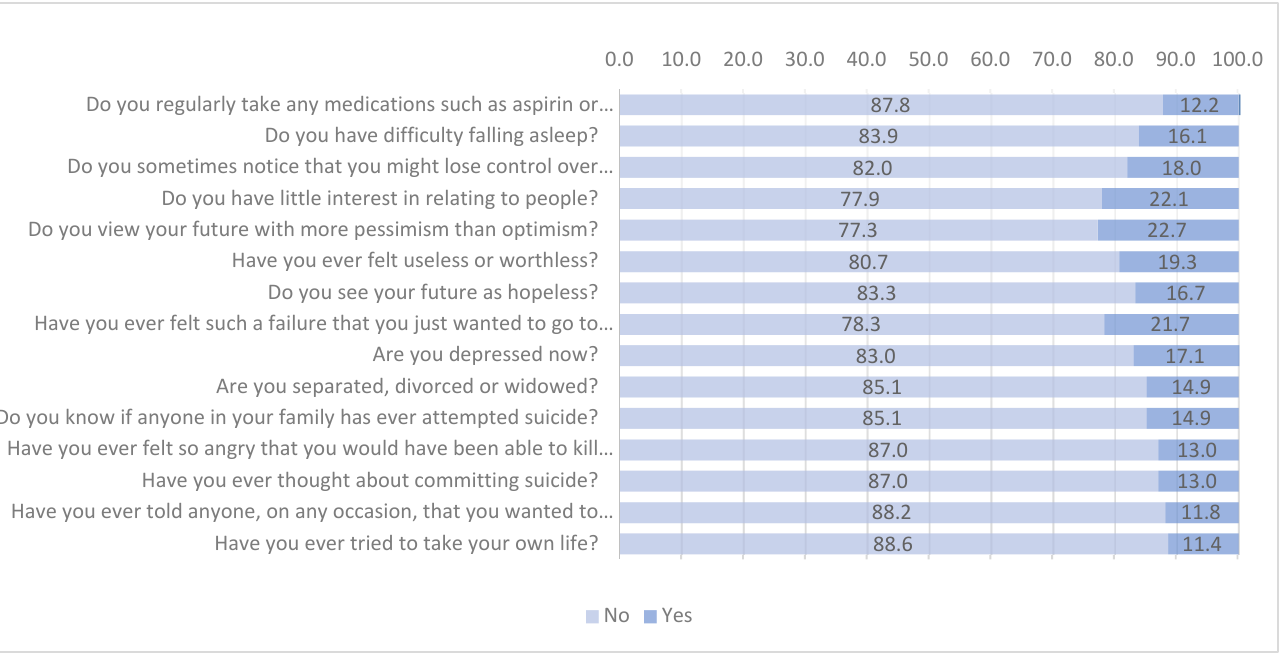
Figure 1. Frequency of responses according to each item of the Plutchik suicide risk scale. In the bivariate analysis (Table 2), significant differences were found in the prevalence of SR, according to being single (16.2% single vs. 7.6% no single, p = 0.014), having children (8.8% children vs. 9.9% no children, p = 0.042), working time (8.8% 19 months or more vs. 19.2% 1 to 6 months, p = 0.047), family history of mental health (40.9% family history vs. 12.8% no family history, p < 0.001), insomnia (44% severe clinical insomnia vs. 11.3% absent insomnia, p < 0.001), resilience (7.1% high resilience vs. 19.4% low resilience, p < 0.001). Likewise, with mental health outcomes, anxiety (63.6% severe anxiety vs. 8.2% no anxiety, p < 0.001), depression (50% severe depression vs. 8.5% minimal depression, p < 0.001), and PTSD (29.7% PTSD vs. 12.8% no PTSD, p = 0.004). Table 2. Characteristics associated with suicidal risk in military personnel. Suicidal Risk p *No ( n = Variables